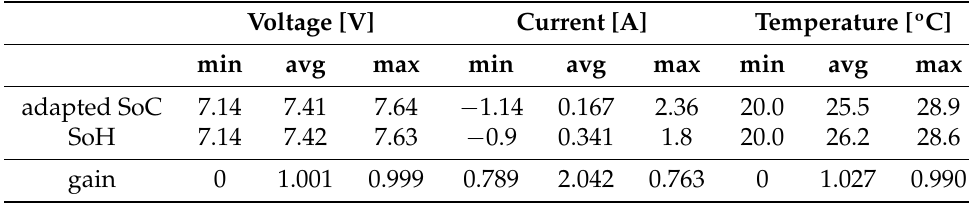
Table 10. Battery 1 during a month of simulation: Case 2.